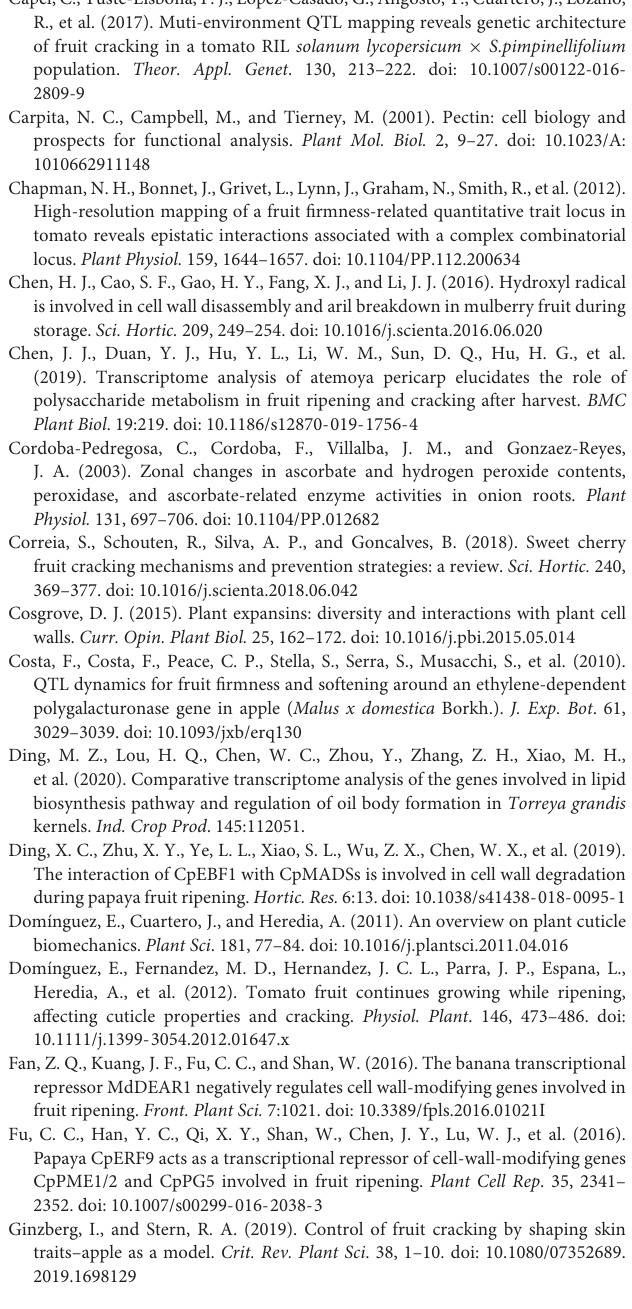
Supplementary Table 1 | Quality of RNA-Seq libraries and the number of differentially expressed genes (DEGs) between arils at 96 and 141 DASP. Supplementary Table 2 | Summary of the total number of transcripts and the FPKM identified from different stages and replicates. Supplementary Table 3 | Summary of KEGG pathway functional enrichment analysis of DEGs between 96 and 141 DASP at the transcript level. Supplementary Table 4 | Sequences of specific primers used for the qPCR